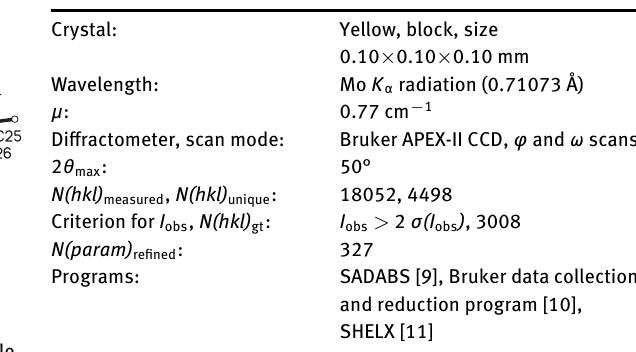
Table 1: Data collection and handling.